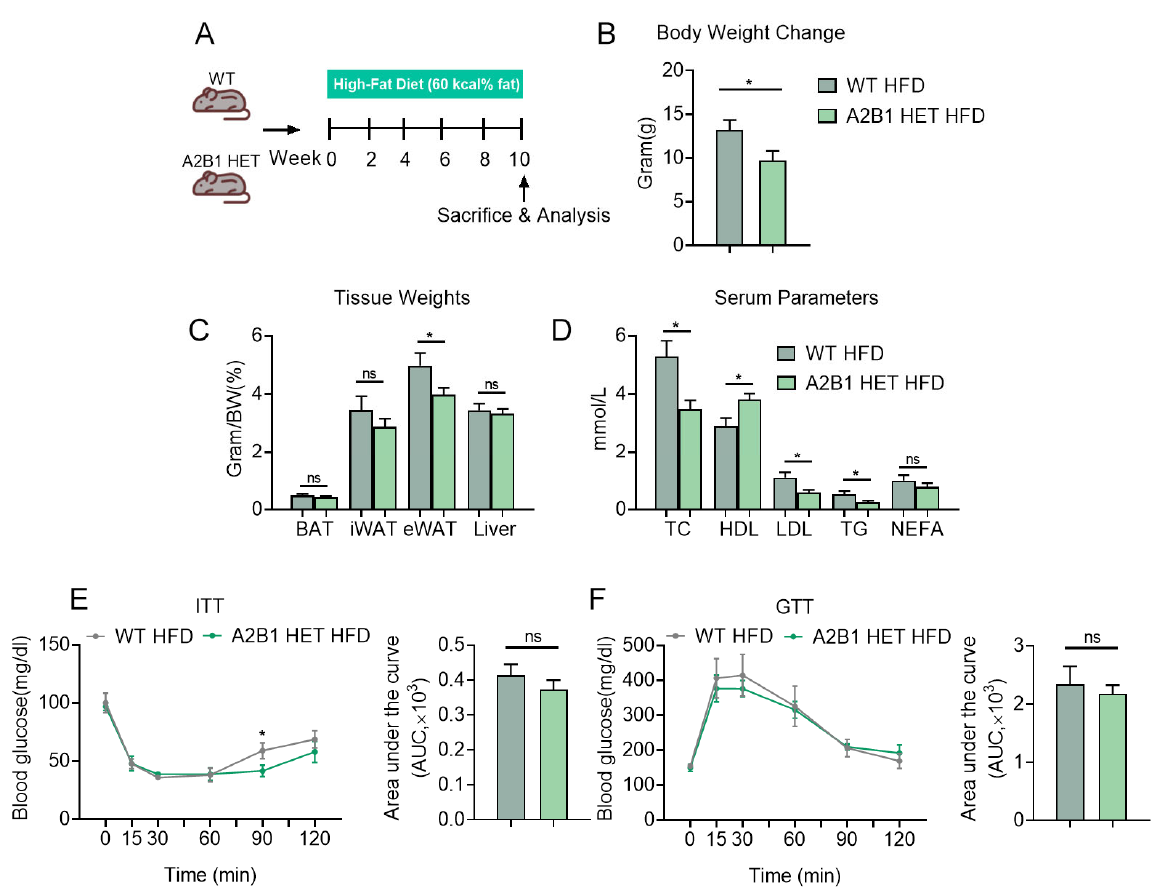
Figure 4. hnRNPA2B1 heterozygous mice under high-fat-diet-induced obesity. ( A ) Schematic rep- resentation of the experimental timeline and design. ( B – E ) Body weight change ( B ), weights of met- abolic tissues including brown fat, inguinal fat, epididymal fat and liver ( C ), serum parameters in- cluding TC, HDL, LDL, TC and NEFA levels ( D ), ITT ( E ) and GTT ( F ) of WT and A2B1 HET mice after high-fat diet for 10 weeks. Results are shown as mean ± SEM; ns, not signi fi cant; * p < 0.05.